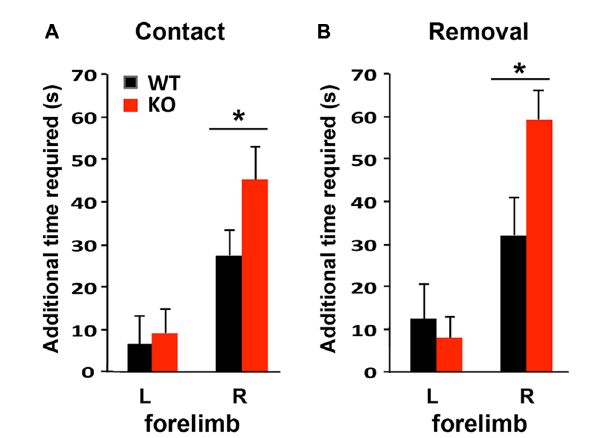
FIGURE 5 | Sensory-motor function is more severely impaired in IRF2BP2KO mice after ischemic injury of the left sensory motor cortex as revealed by the adhesive removal test. Mice were subjected to adhesive removal tests to compare the time needed to remove adhesive tape on the left and right paws 1 week before vs. 4 days after stroke. IRF2BP2KO mice need more time to detect (contact time, A ) and remove (removal time, B ) the adhesive tape on their right paw after stroke. N = 10–15 mice/group. ∗ p < 0.05.